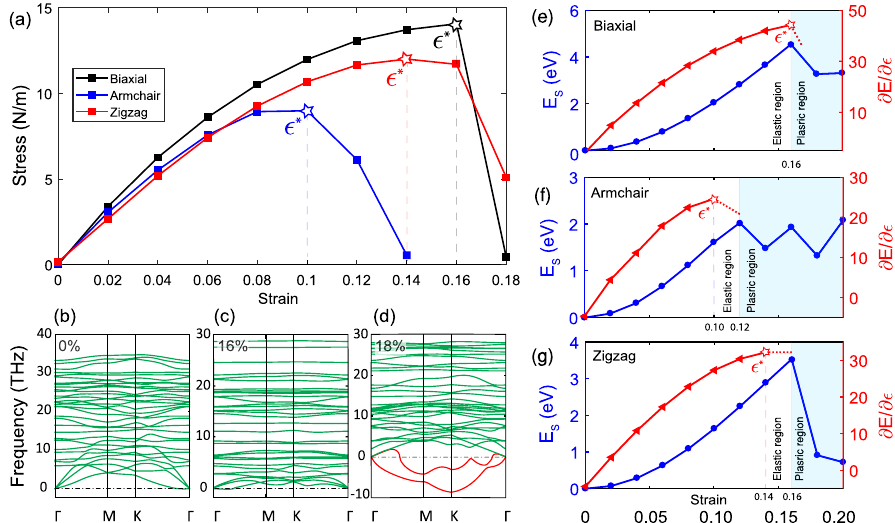
Figure 3. ( a ) Stress–strain curve in the range of 0 to 18% for obtaining the ideal strength. ( b – d ) Phonon band structure under different biaxial strains. ( e – g ) The energy/strain and energy-gradient/strain curves in the range of 0 to 20% used to calculate the traditional elastic and plastic regions for biaxial, armchair, and zigzag